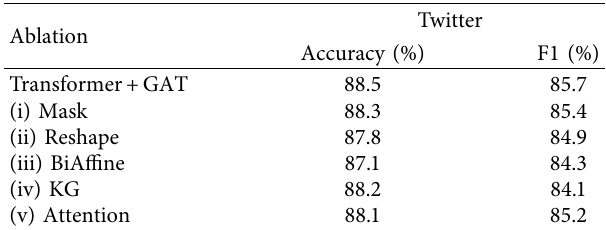
Figure 9: Early detection accuracy of rumors, accuracy obtained from Twitter datasets sent by posts and test posts scanned incrementally. Table 6: accuracy and F1 obtained after adding five typical ablation